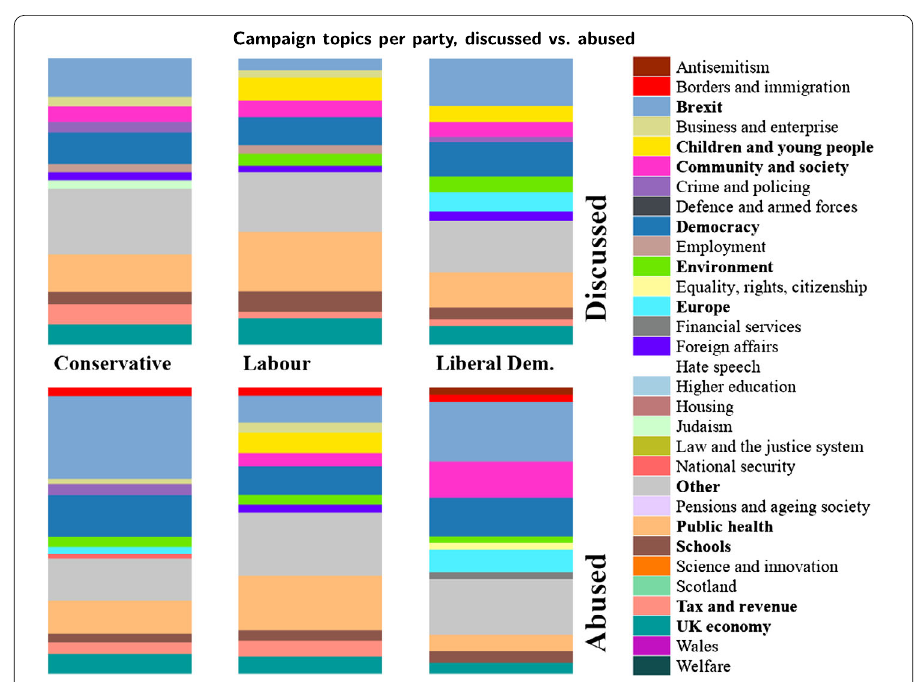
Figure 10 Campaign topics per party, discussed vs. abused. In the top part of the figure, the nine topics most mentioned in tweets by candidates of each party are shown in a stacked bar chart of tweet counts, with remaining topics in the “other” category. In the lower part, in the same order, topics are counted according to abusive replies they drew. For example, we see that the Brexit section is considerably larger in the lower part of the figure for Conservative candidates, indicating that when they mention Brexit they tended to draw more abuse. On the other hand, when they mentioned community and society they drew less